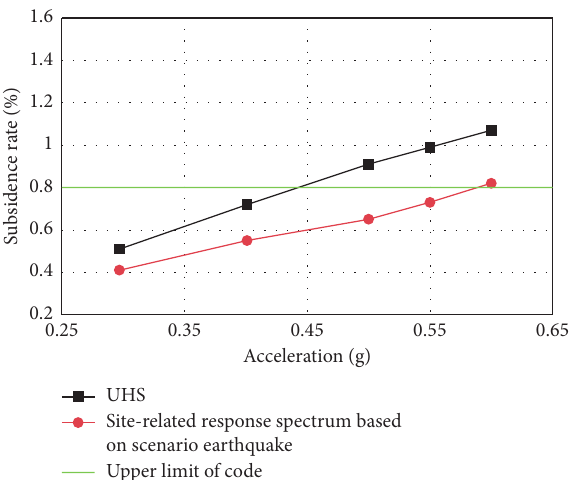
Figure 14: Earthquake-induced settlement with acceleration using different response spectra.